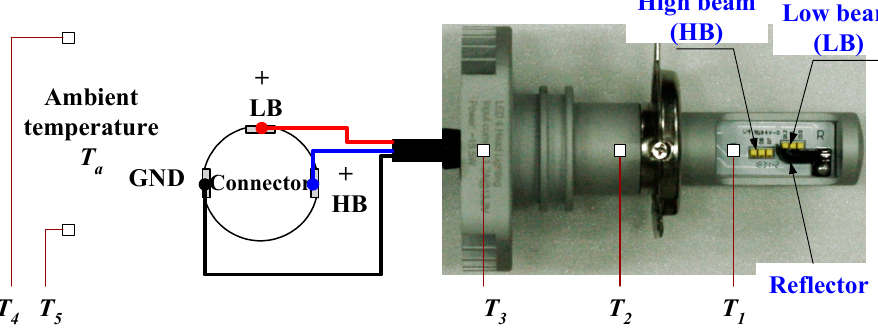
Figure 2. Photograph of automotive LED lamp and schematic diagram of measurement position.